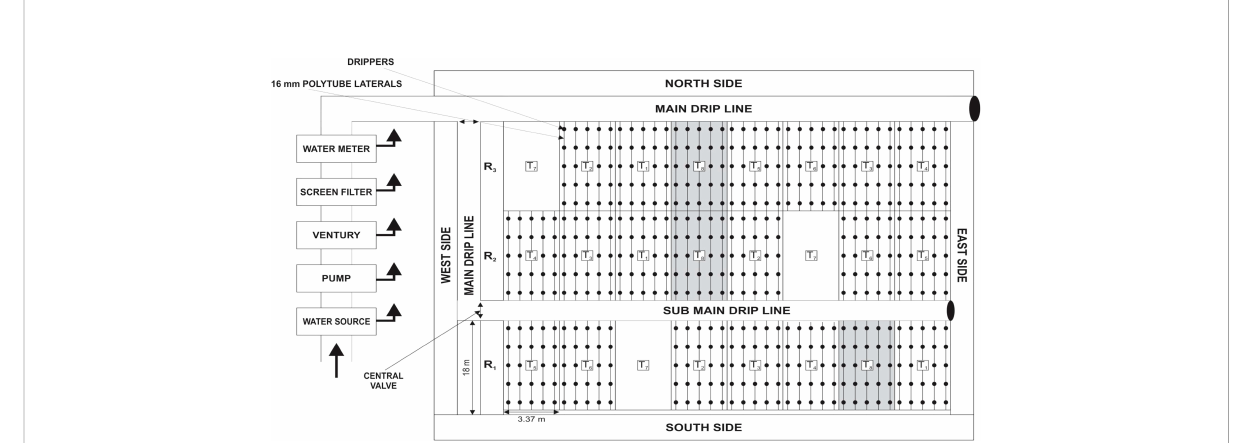
FIGURE 1 Layout of the experimental plots showing different treatments and drip line